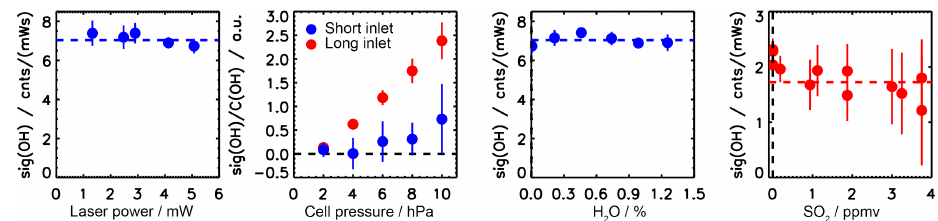
Figure 6. OH signals from limonene or α -pinene ozonolysis depending on various parameters: laser power (1ppmv α -pinene, 110ppbv O 3 , cell with short inlet), cell pressure (45ppbv limonene, 350ppbv O 3 , 1000ppmv propane), water vapour (1ppmv α -pinene, 110ppbv O 3 , cell with short inlet), and SO 2 (40ppbv limonene, 550ppbv O 3 , 400ppmv propane, cell with long inlet). No propane was added for testing the laser power and water vapour dependencies. In these two cases, the concentration of α -pinene was chosen to be high enough, such that the OH signal was dominated by internally produced OH in the detection cell.